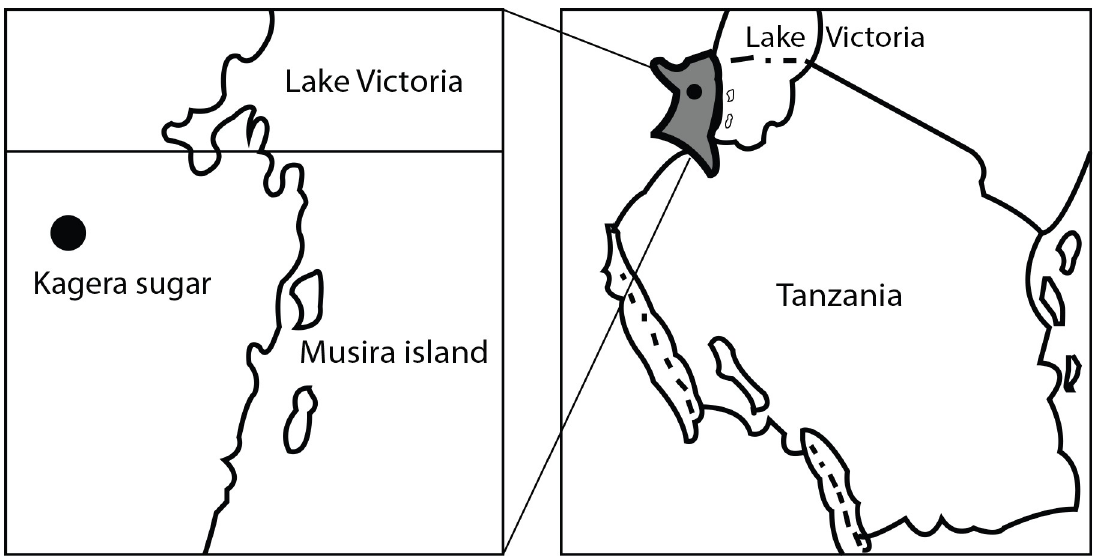
Fig 1. Map of Tanzania showing location of Kagera region and the study locations of fishing community (Musira island) and sugarcane plantation at Kagera sugar company.